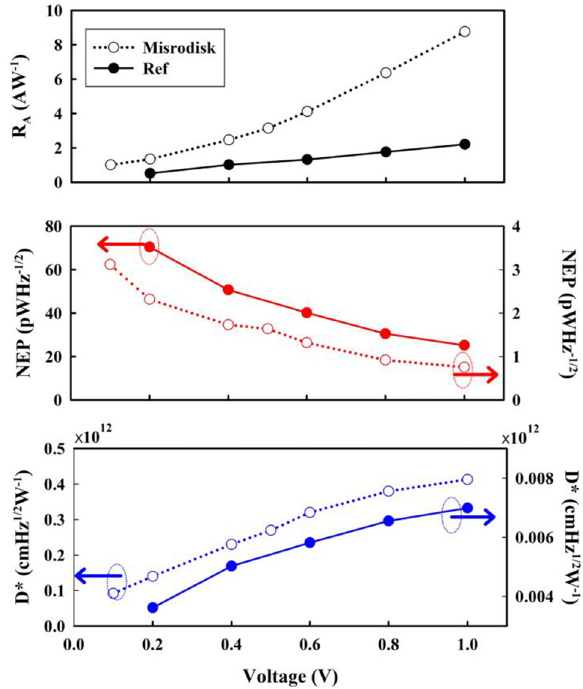
, NEP, and D ∗ of the devices at different voltage bias at Figure 4: R A room